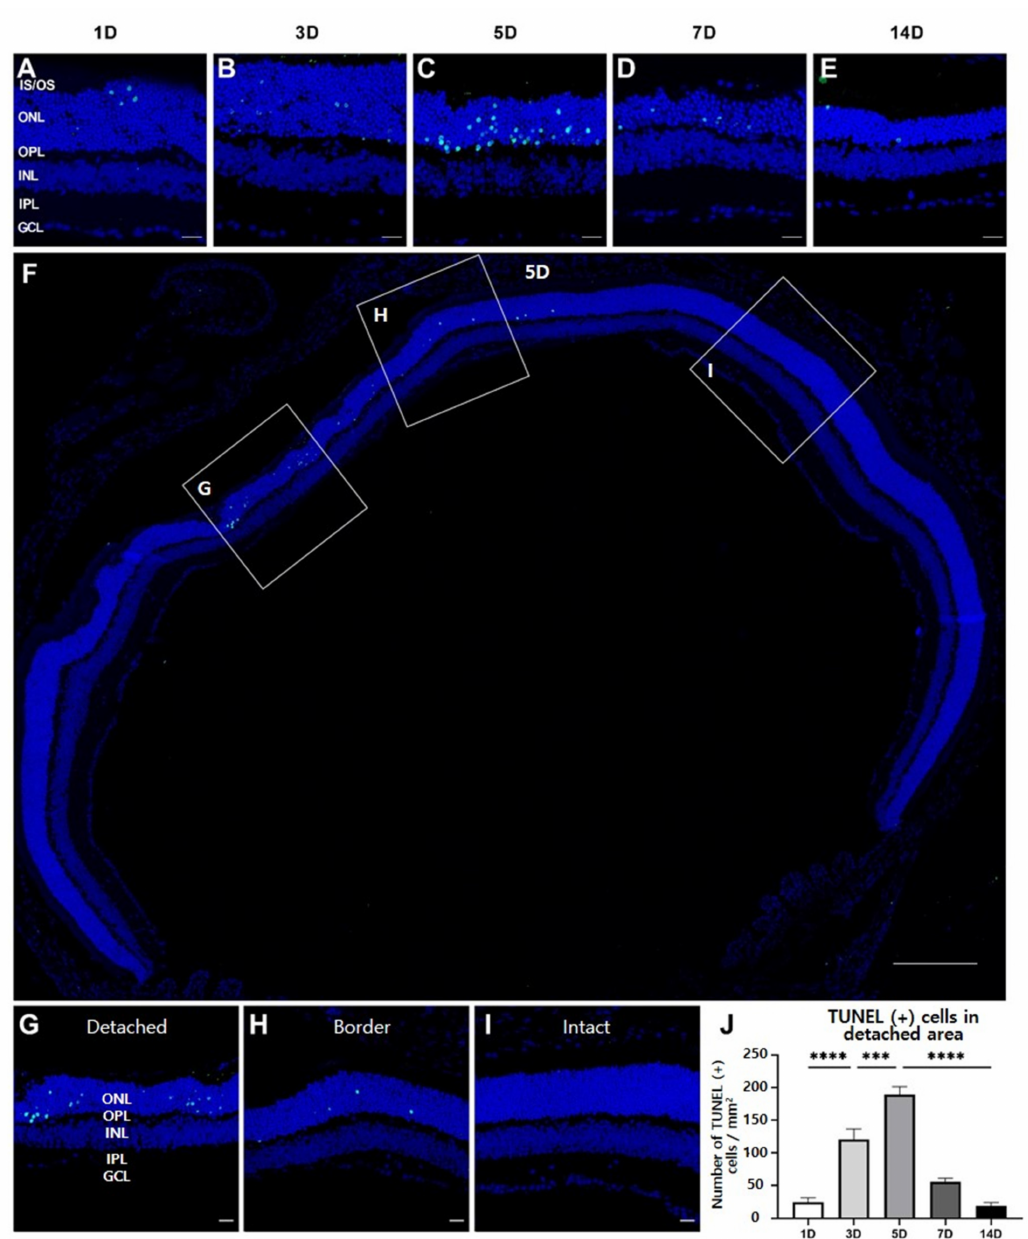
Figure 2. TUNEL assay to evaluate the apoptotic cell death in RD. ( A – E ) TUNEL-positive cells mostly observed in ONL of the detached region were significantly increased 5 days after RD, and, thereafter, decreased by 14 days. Scale bars, 20 µ m. ( F ) A low-magnification view 5 days after RD. Scale bar, 200 µ m. ( G – I ) TUNEL-positive cells located at photoreceptors were present in the ( G , H ) detached and border regions, but not in the ( I ) intact region. Scale bars, 20 µ m. ( J ) Quantitative analysis of the number of TUNEL-positive cells was manually conducted ( n = 5, 5 fields per time point). Data are shown as mean ± SEM. *** p < 0.001 and **** p < 0.0001 based on one-way ANOVA followed by Bonferroni’s multiple comparisons